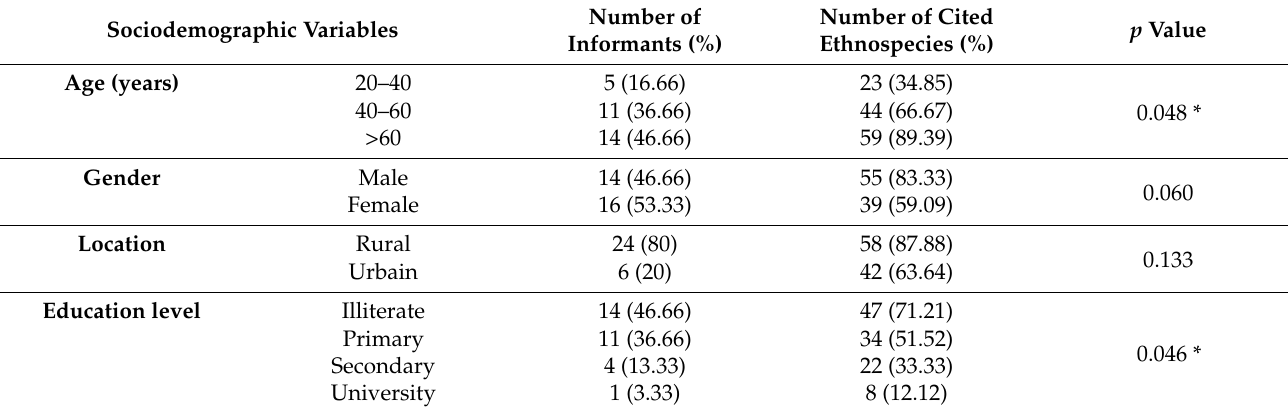
Values with * indicate the significant correlation of the number of cited ethnospecies with the sociodemographic variable (* p < 0.05).